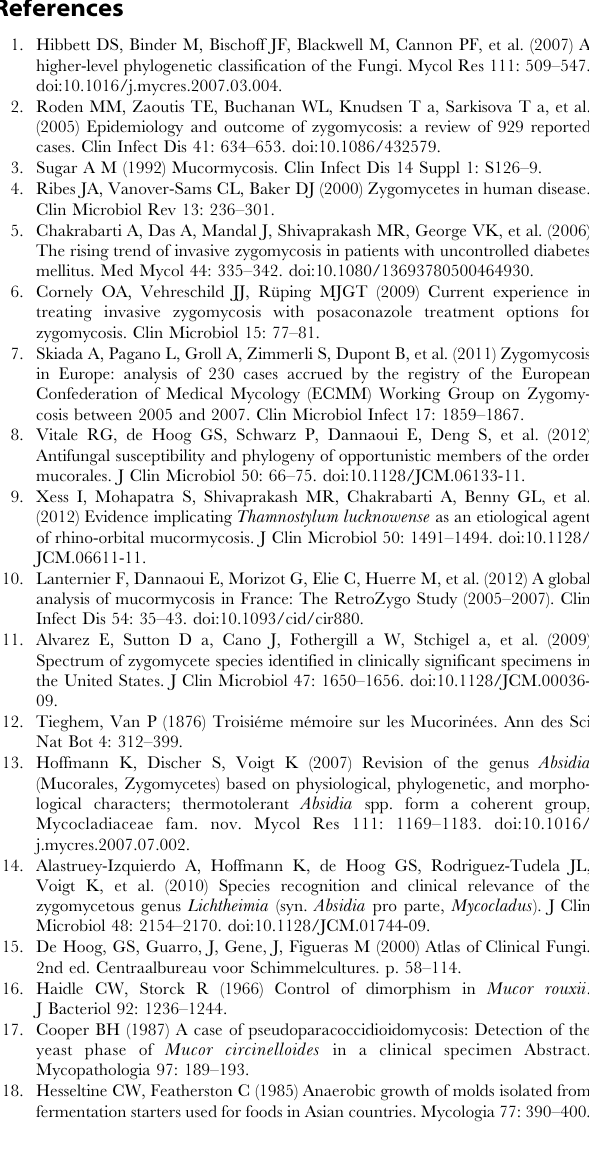
Table S9 Genomes used in this study.